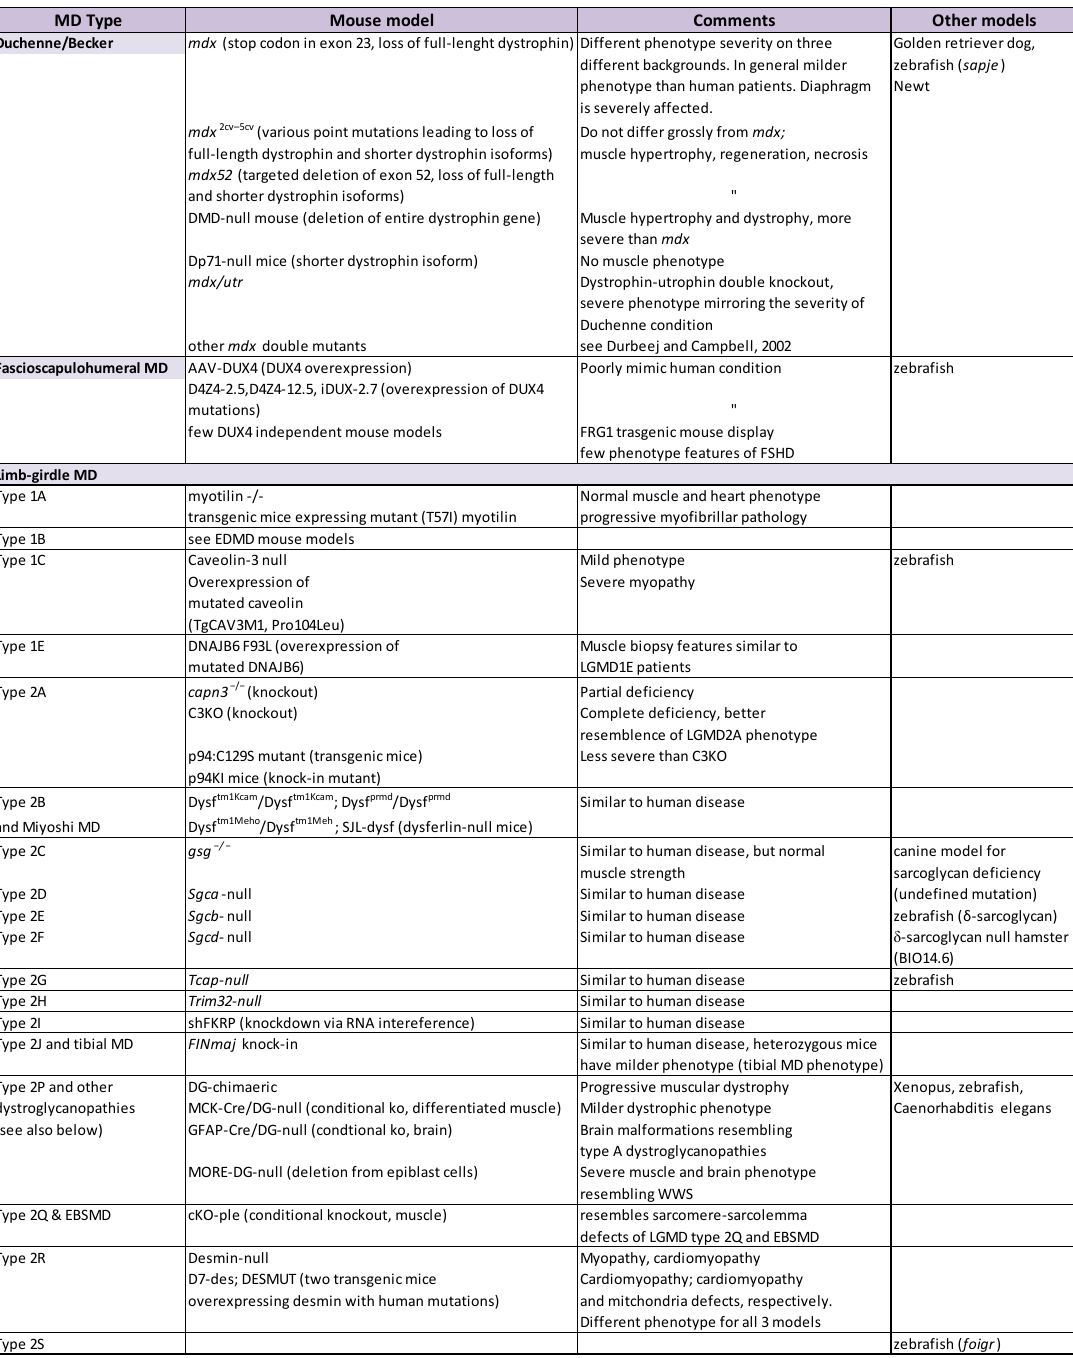
Table 3. Animal models for MD. Based on [23,24]; Mouse Genome Informatics Database http://www.informatics.jax.org/. CNS: central nervous system; ko: knockout; WWS: Walker-Warburg syndrome; MEB: muscle-eye-brain disease; MTJ: myotendinous junction.